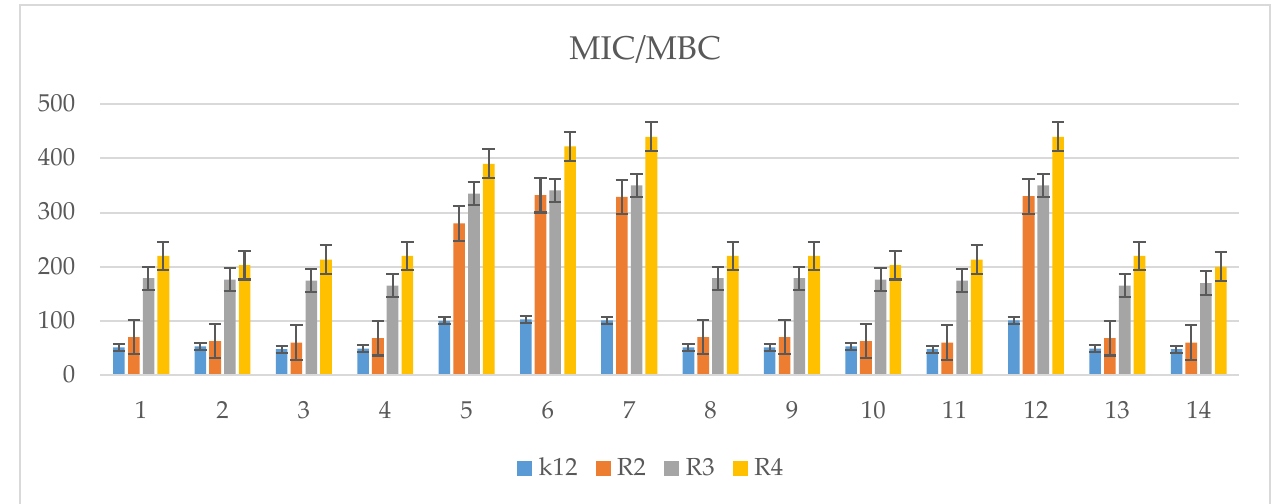
Figure 6. The ratio of MBC/MIC of the β -phosphonate derivatives. The x -axis features compounds 1 – 16 used sequentially. The y -axis shows the MIC value in µg/mL −1 . Investigated strains of E. coli K12 as control (blue), R2 strains (orange), R3 strain (grey), and R4 strain (yellow). The y -axis shows the MBC value in µg/mL −1 . The order in which the compounds were applied to the plate is shown in Supplementary Materials Figure S1.